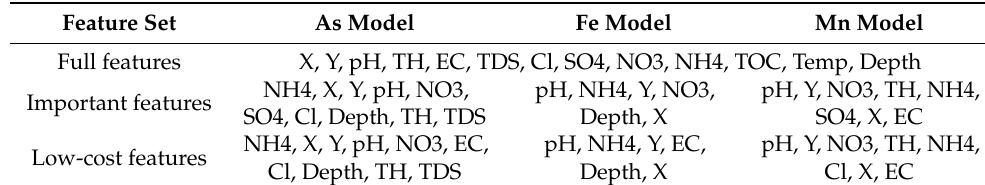
Table 4. Feature grouping for models.